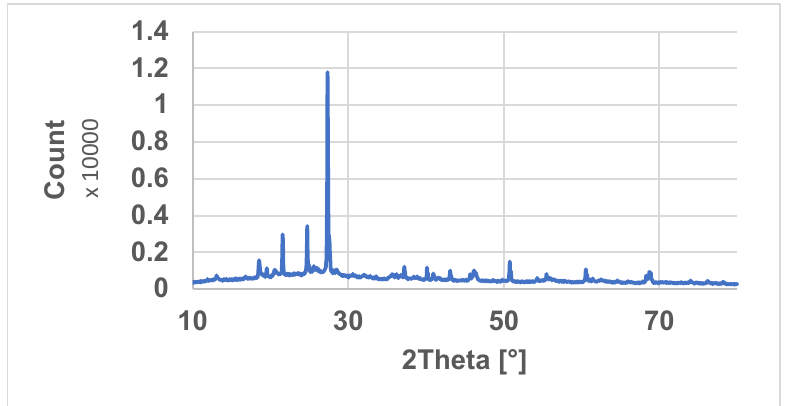
Figure 1. XRD pattern of natural clay.